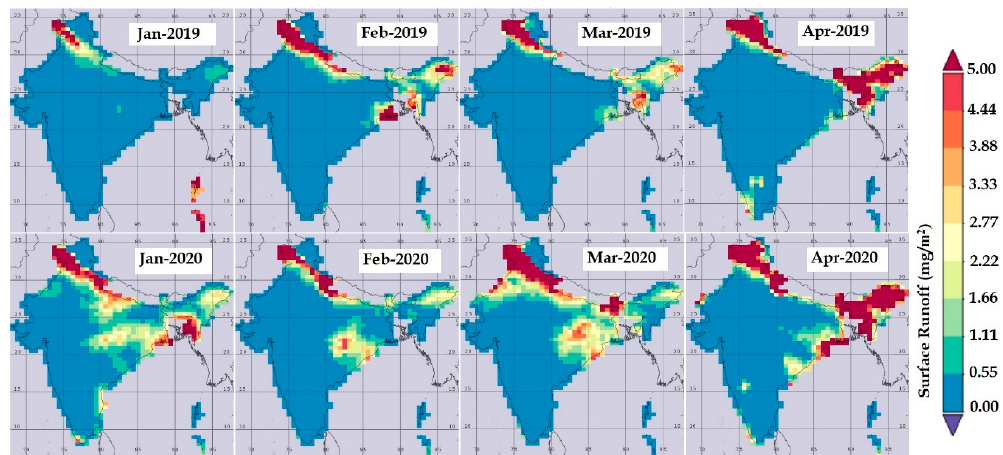
Figure 3. Spatio-temporal variability of overland runoff for India using the MERRA-2 model (M2TMNXLND v5.12.4) derived time averaged monthly runoff maps (spatial resolution: 0.5 × 0.625 degree). The maps were produced in NASA’s GIOVANNI (https://giovanni.gsfc.nasa.gov/giovanni/) web-based interactive tool. The runoff unit was converted from Kg/m 2 to mg/m 2 to visualize the spatial variability effectively.